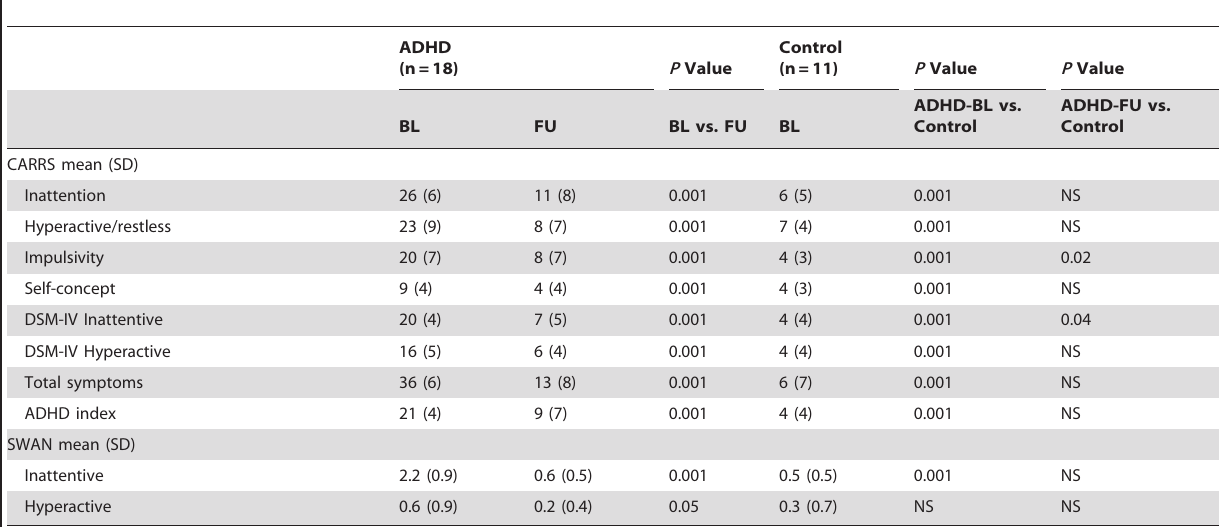
*CAARS: Conners Adult Attention Rating Scale. *SWAN: Strengths & Weaknesses of ADHD Symptoms & Normal-Behaviors. *NS: not significant.